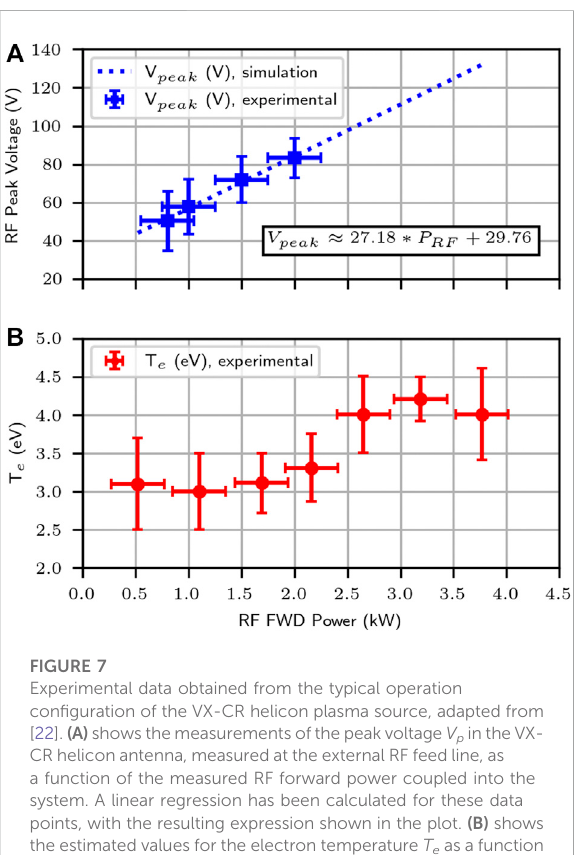
FIGURE 7 Experimental data obtained from the typical operation con fi guration of the VX-CR helicon plasma source, adapted from [22]. (A) showsthemeasurementsofthepeakvoltage V p intheVX- CR helicon antenna, measured at the external RF feed line, as a function of the measured RF forward power coupled into the system. A linear regression has been calculated for these data points, with the resulting expression shown in the plot. (B) shows the estimated values for the electron temperature T e as a function of RF forward power, obtained from measurements with the reciprocating Langmuir probe. Experimental techniques and measurement uncertainties for these data points have been described in [22].